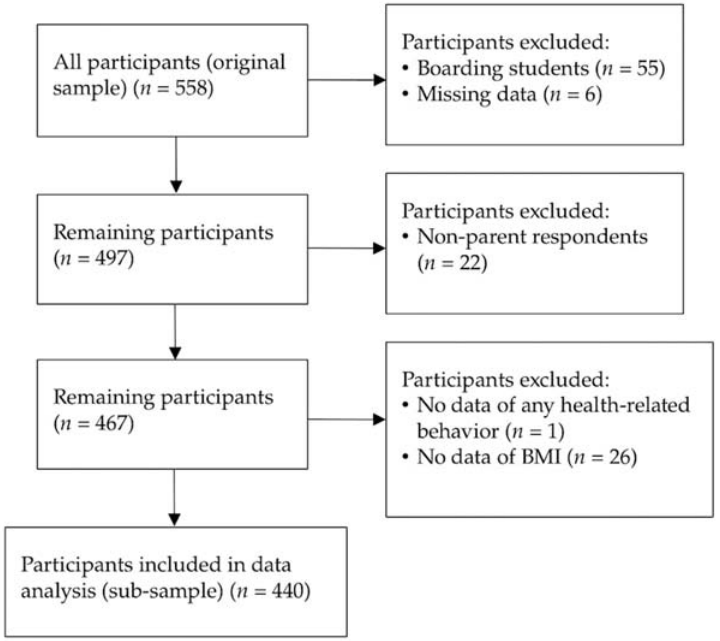
Figure 1. Flow chart of participant selection.